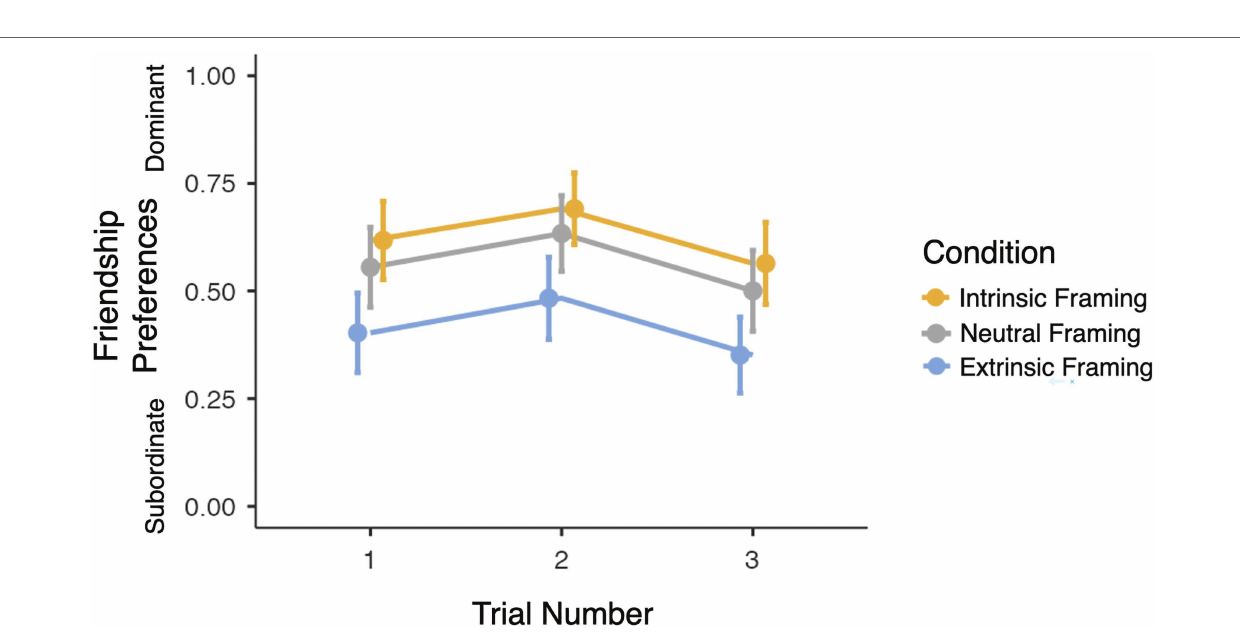
FIGURE 4 | Impact of framing condition on friendship preferences. Higher scores represent preferences moreso favoring the dominant over the subordinate group. Scores of 0.5 represent chance performance on the forced-choice trials. Error bars represent +/ − 1